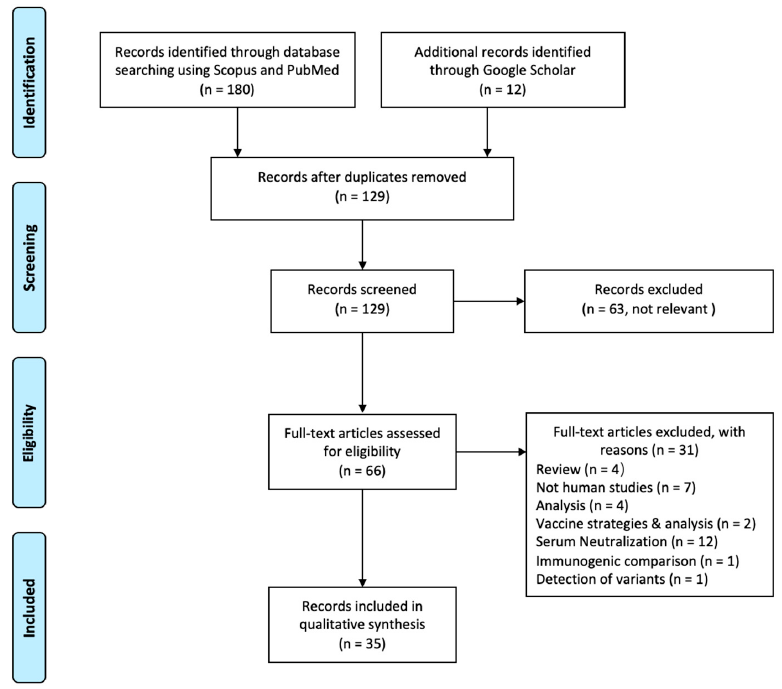
Figure 2. PRISMA Flow Diagram.